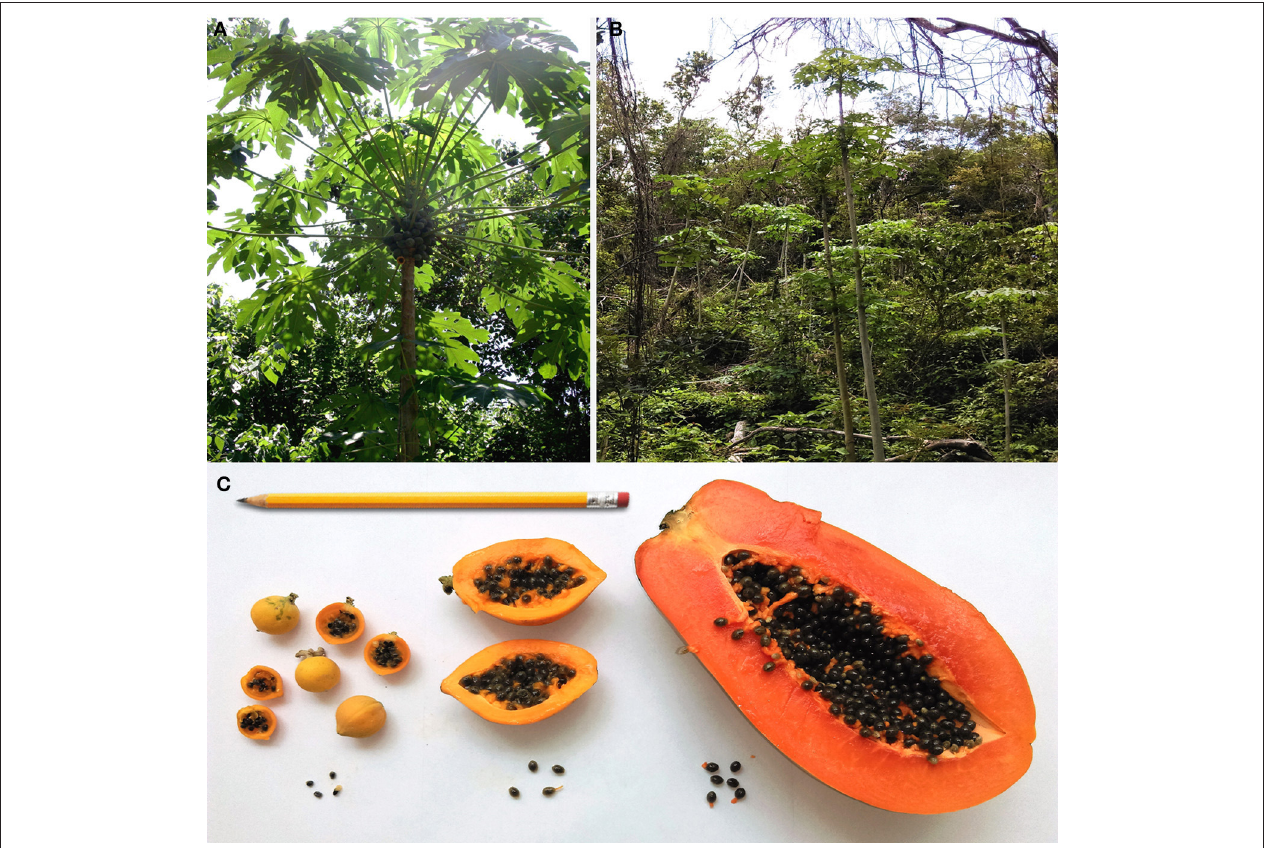
FIGURE 1 | (A) Wild female papaya tree with fruits in Yucatan, Mexico. (B) Wild population of Carica papaya in Yucatan, Mexico. (C) Wild fruits, intermediate form fruits (possible hybrid between wild and domesticated plants), and domesticated papaya fruit (Maradol